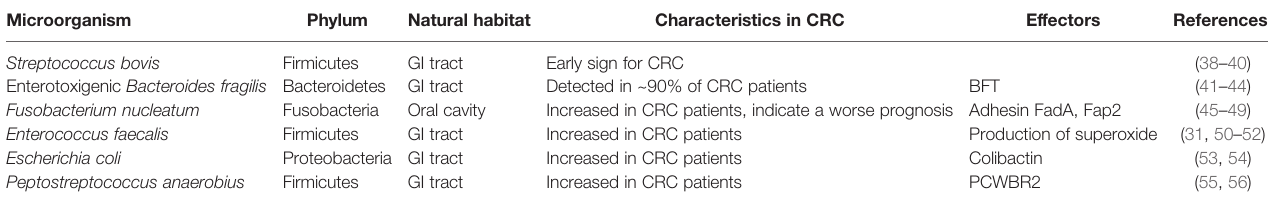
TABLE 1 | Colorectal cancer associated intestinal microorganism. Microorganism Phylum Natural